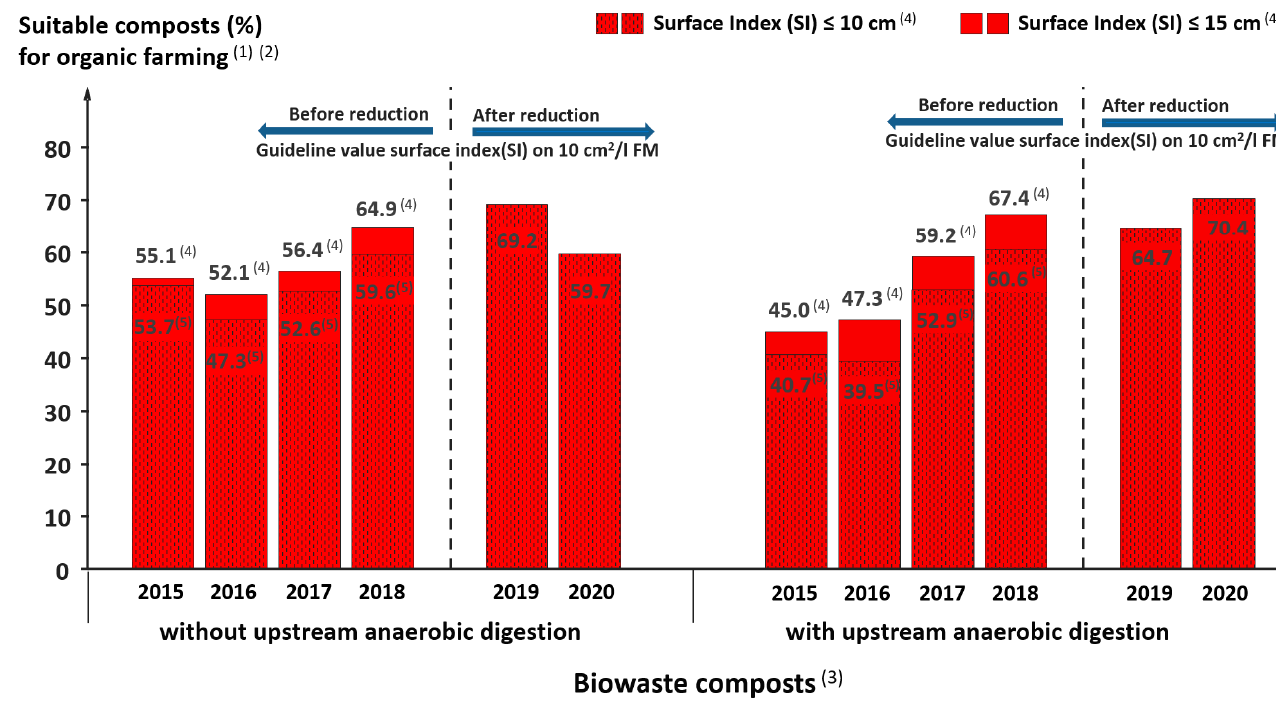
Figure 4. Differences in suitability of quality-assured biowaste composts with and without upstream anaerobic digestion according to RAL-GZ 251 Compost of the BGK with regard to their use in organic farming in Germany in 2015 to 2020 (1) . (1) Limit values ( ≤ ) according to EU-ÖkoV—EU Regulations on organic farming (Regulation (EC) No. 889/2008, Annex 1 resp. 2021/1165, Annex 2; guideline values ( ≤ ) according to Bioland/Naturland guidelines (5/2014 to 3/2020). (2) % of all analyzed composts according to RAL-GZ 251 Compost. (3) n = 1856 in 2015, n = 1857 in 2016, n = 1843 in 2017, n = 1900 in 2018, n = 1874 in 2019, n = 1899 in 2020, data from RAL quality assurance 251 compost (BGK, 2016–2021). (4) Incl. foreign matter (also parameter surface index (SI)). Foreign matter is not regulated according to EU-ÖkoV but to Bioland/Naturland guidelines. Composts according to Bioland/Naturland guidelines are regulated with guideline surface index (SI) ≤ 15 cm 2 /l FM from 2015 to 2018, ≤ 10 cm 2 /l FM from 2019 onwards. (5) Composts with theoretical application of a reduced guideline value for surface index (SI) ≤ 10 cm 2 /l FM also already from 2015 to 2018 (mandatory only from 2019 onwards)—s. (4) ).